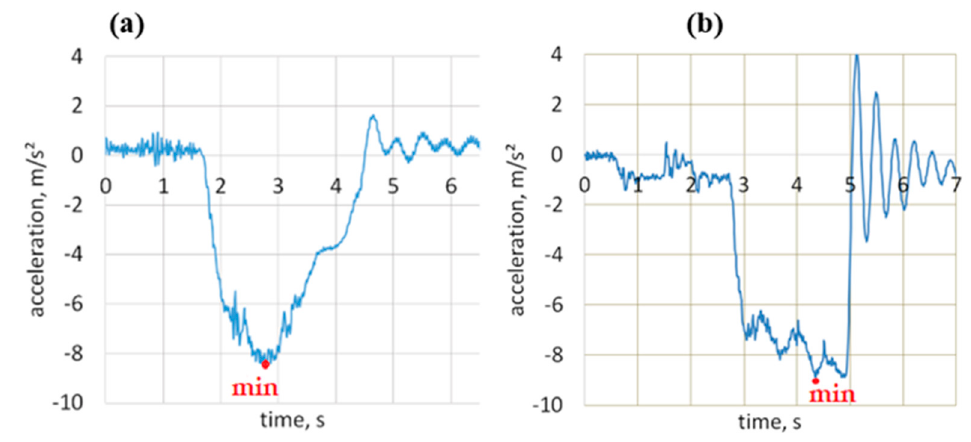
Figure 3. Acceleration profiles during braking for an urban bus ( a ) and a coach ( b ). Multiple measurement cycles involved the recording of the vehicle’s motion parameters, including longitudinal acceleration profiles as a function of time, which were then used to read the minimum values. The data obtained in this way were subjected to statistical analysis. Results are shown in Figure 4.